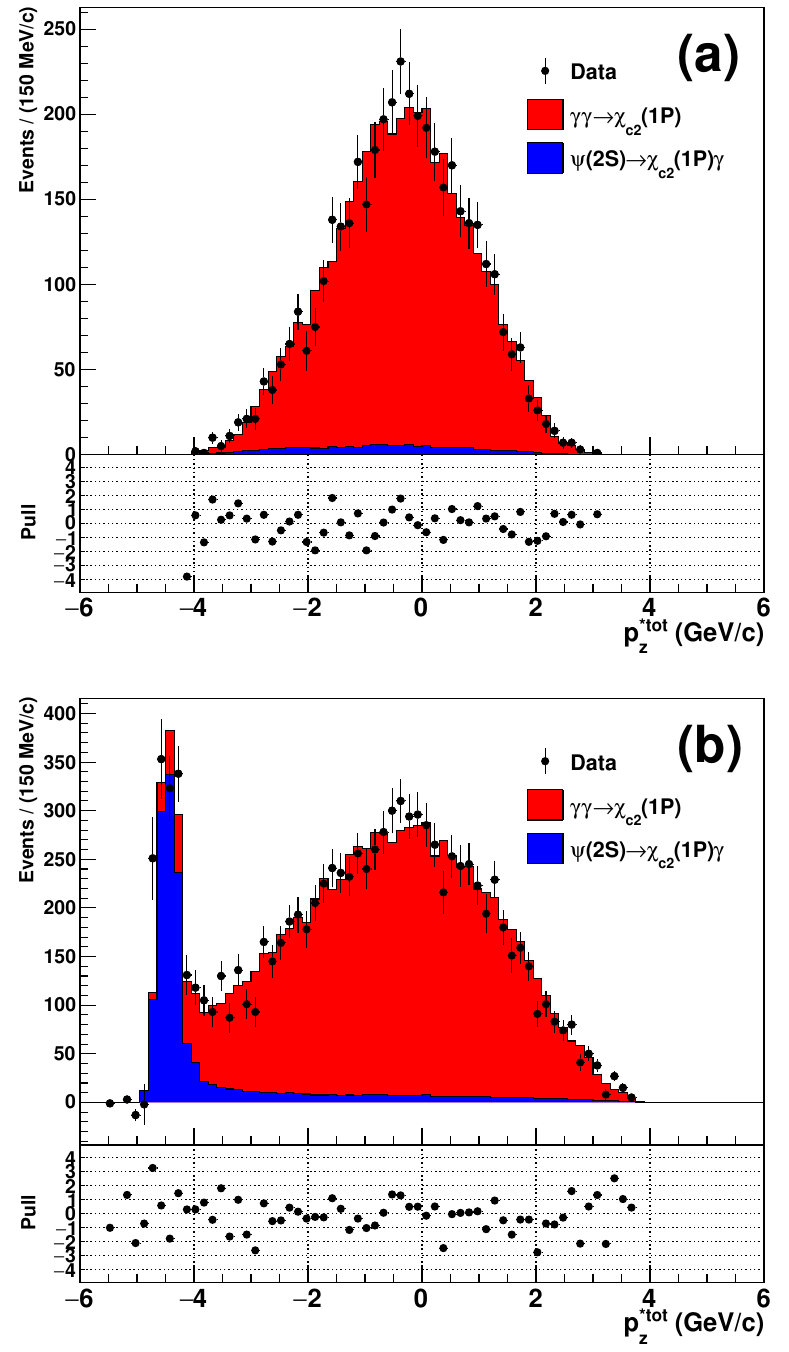
Figure 5 . Distributions of p ∗ tot for the MC and the data sample, with background (estimated z from J/ψ sideband events) subtracted (black points with error bars) after (a) the standard event selection and (b) the loose event selection. The peaking background component (blue histogram) in the MC is normalized based on the total expected number of peaking background events. The signal component (red histogram) in the MC is normalized based on the number of events in the peaking-background-subtracted data